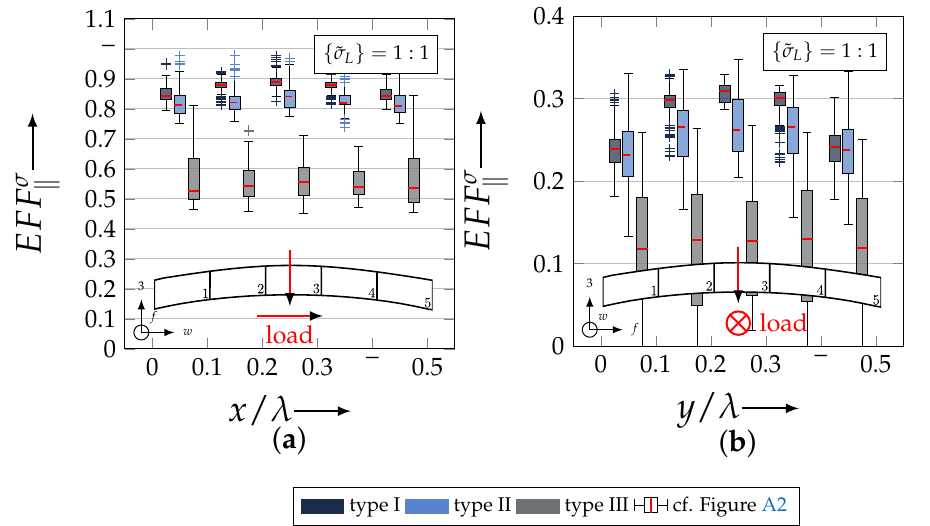
Figure 30. Illustration of stress effort EFF σ load ratio { ˜ σ L } = 1:1 for ( a ) weft and ( b ) fill